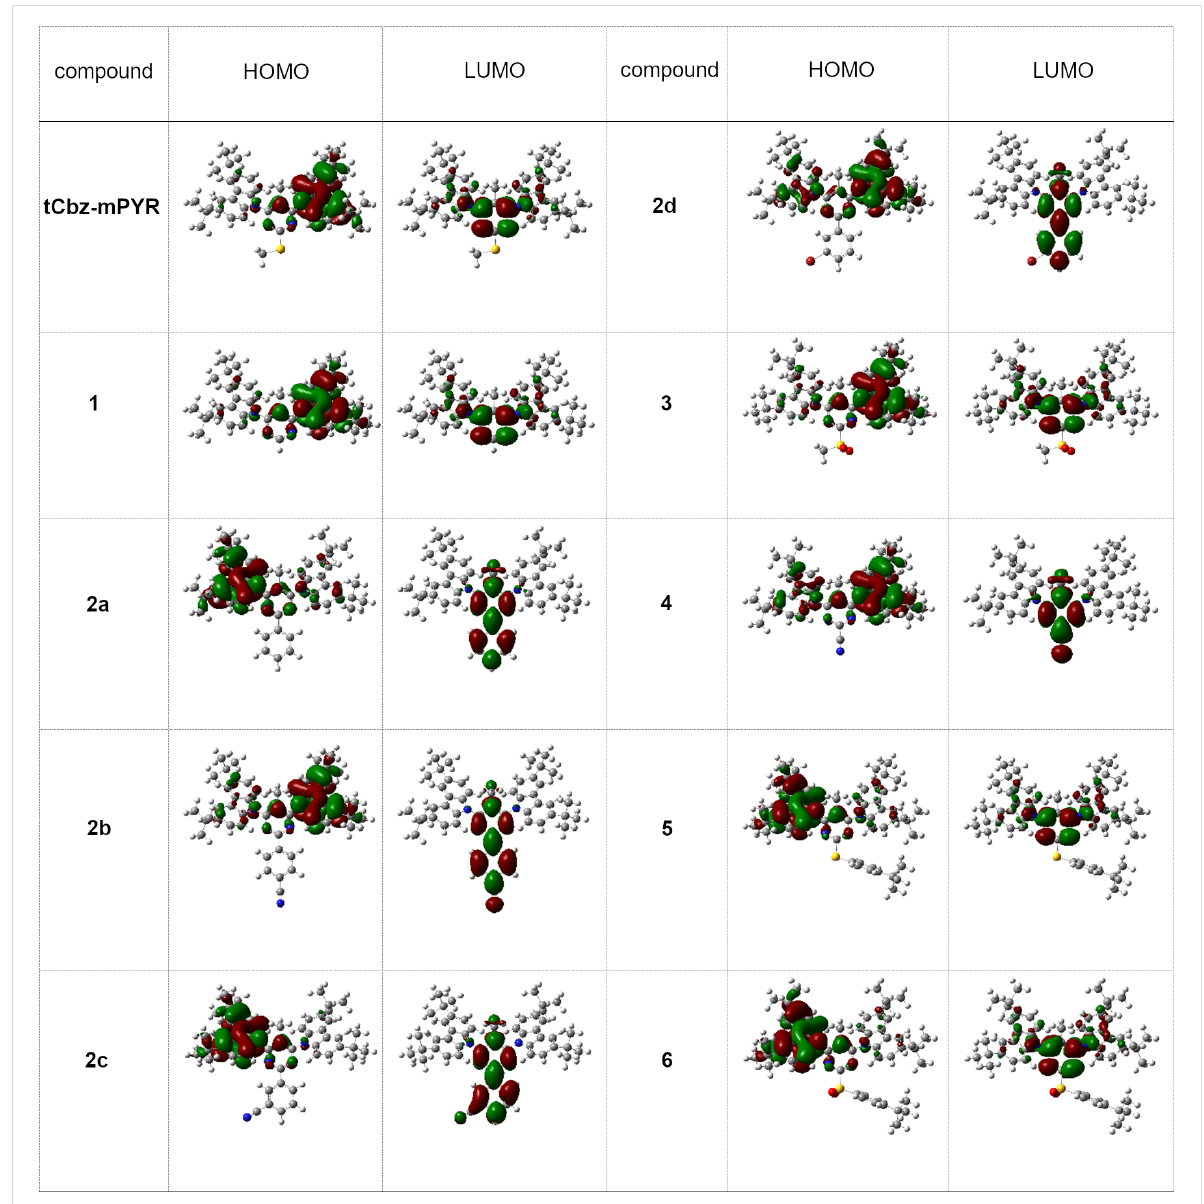
Figure 2: HOMO and LUMO spatial distributions of carbazole–pyrimidine TADF compounds.